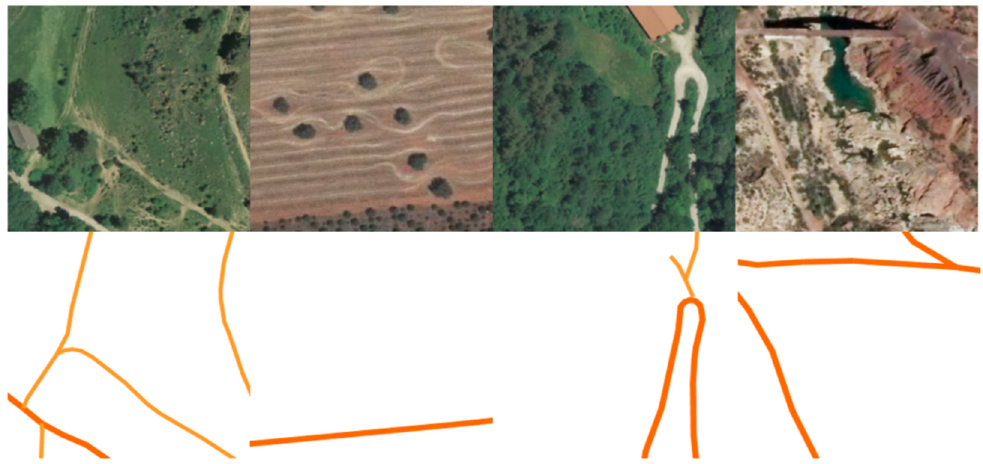
Figure 1. Example of tiles and their rasterized mask with labelled pixels used for training.